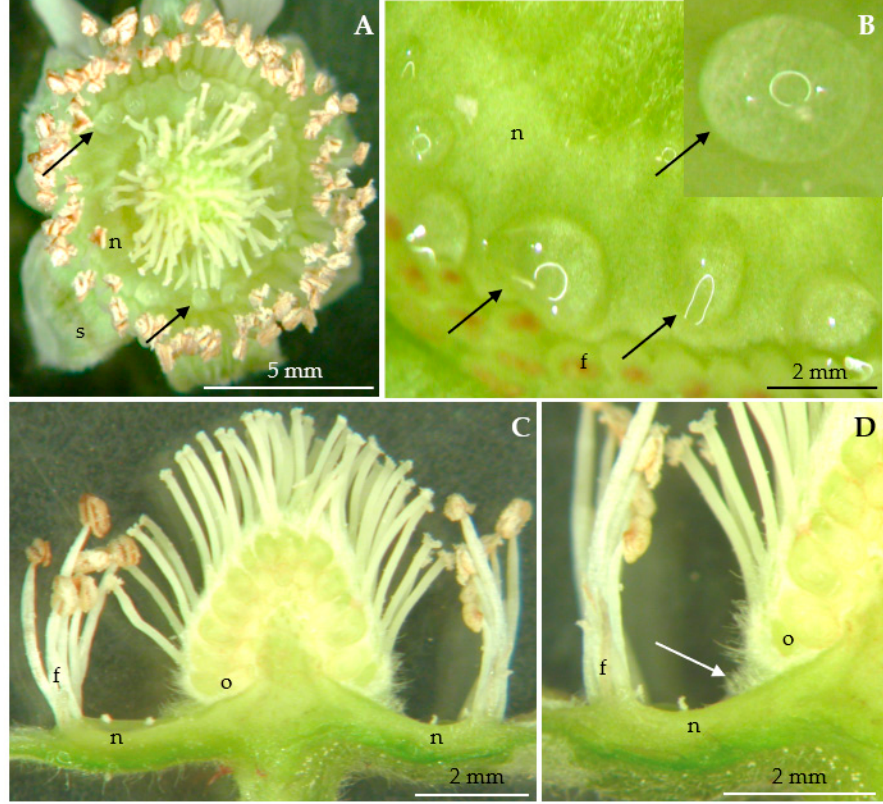
Figure 5. ( A – D ). Flower ( A ), fragments of flower elements and nectaries in R. idaeus ‘Glen Ample’ ( A ), ‘Laszka’ ( B ), ‘Radziejowa’ ( C , D ), in the initial secretion phase ( B ) and in the full nectar secretion stage ( A , C , D ). ( A ): flower with a visible sepal (s), generative elements, nectary (n), and drops of nectar (arrow). ( B ): filaments (f) and nectar droplets on the nectary surface. ( C , D ): longitudinal section of a flower with a visible flat nectary (n) located between the base of stamen filaments (f) and pistil ovary (o), non-glandular trichomes (arrow) (photograph D ).